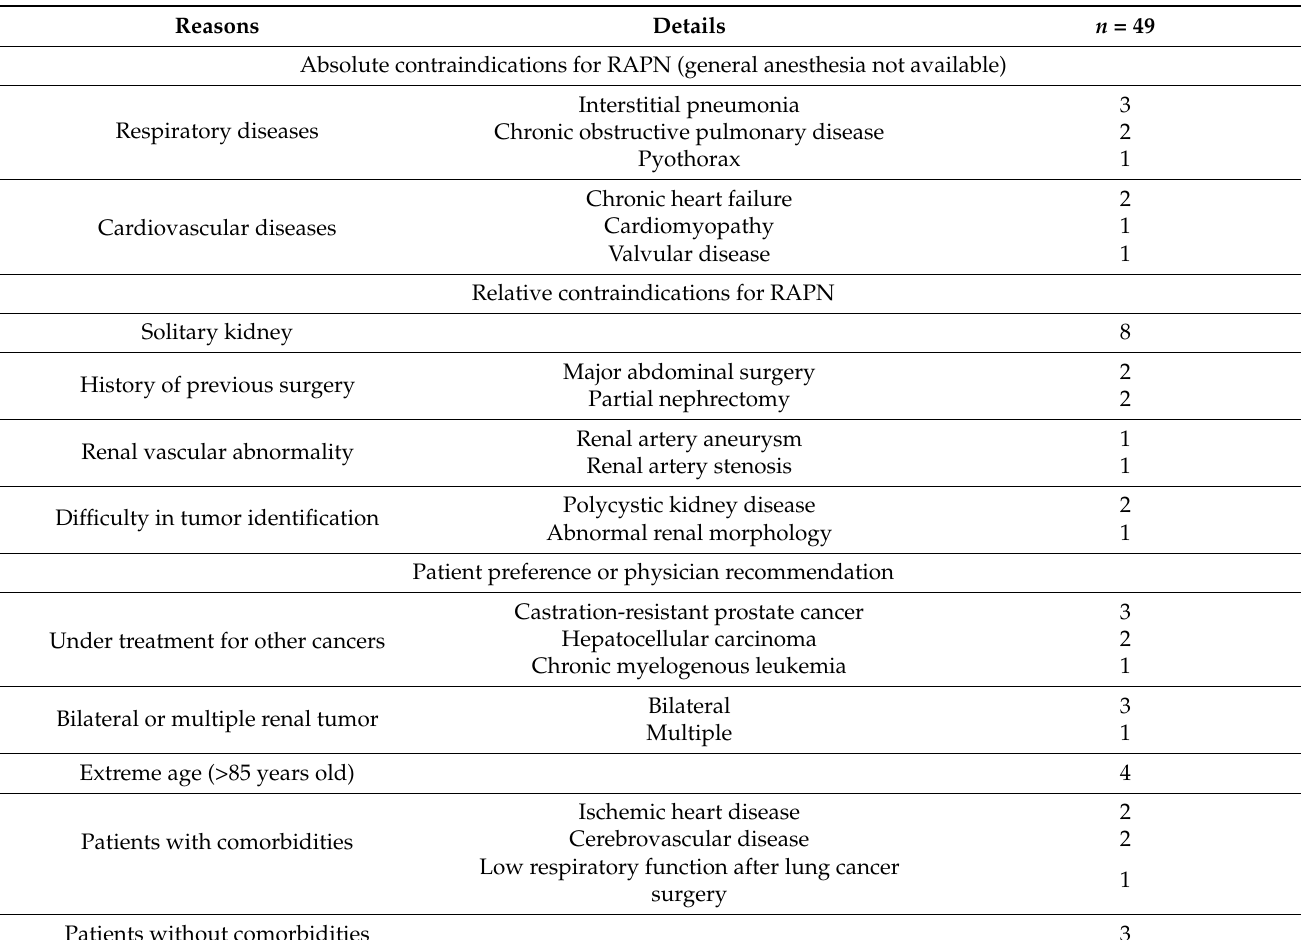
Table 2. Reasons for choosing